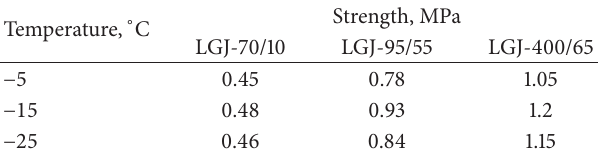
Table 3: The compression strength of iced